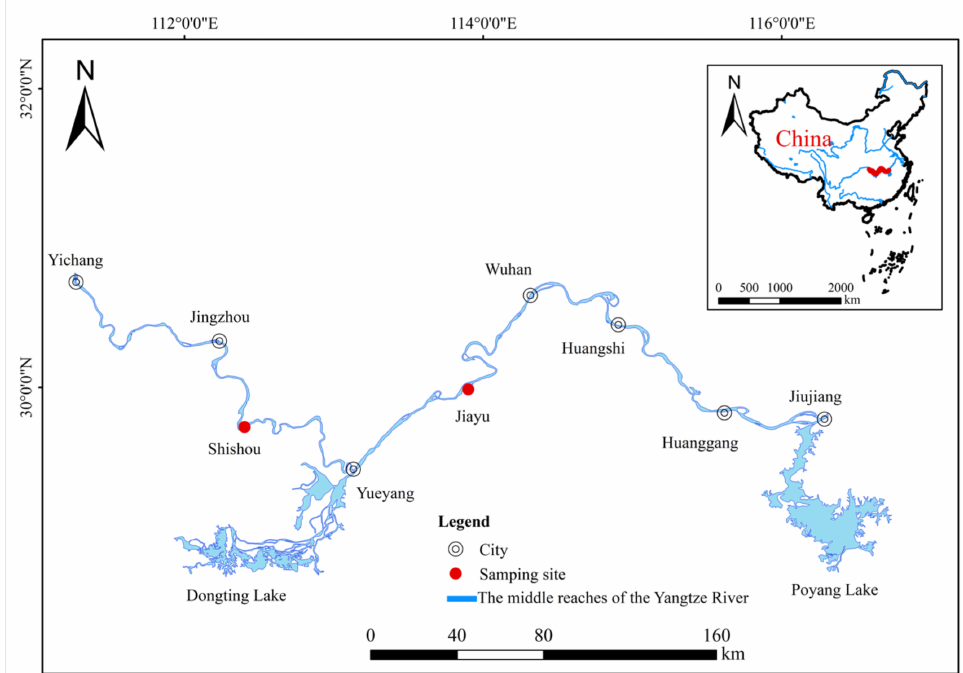
Figure 1. Sampling sites in the middle reaches of the Yangtze